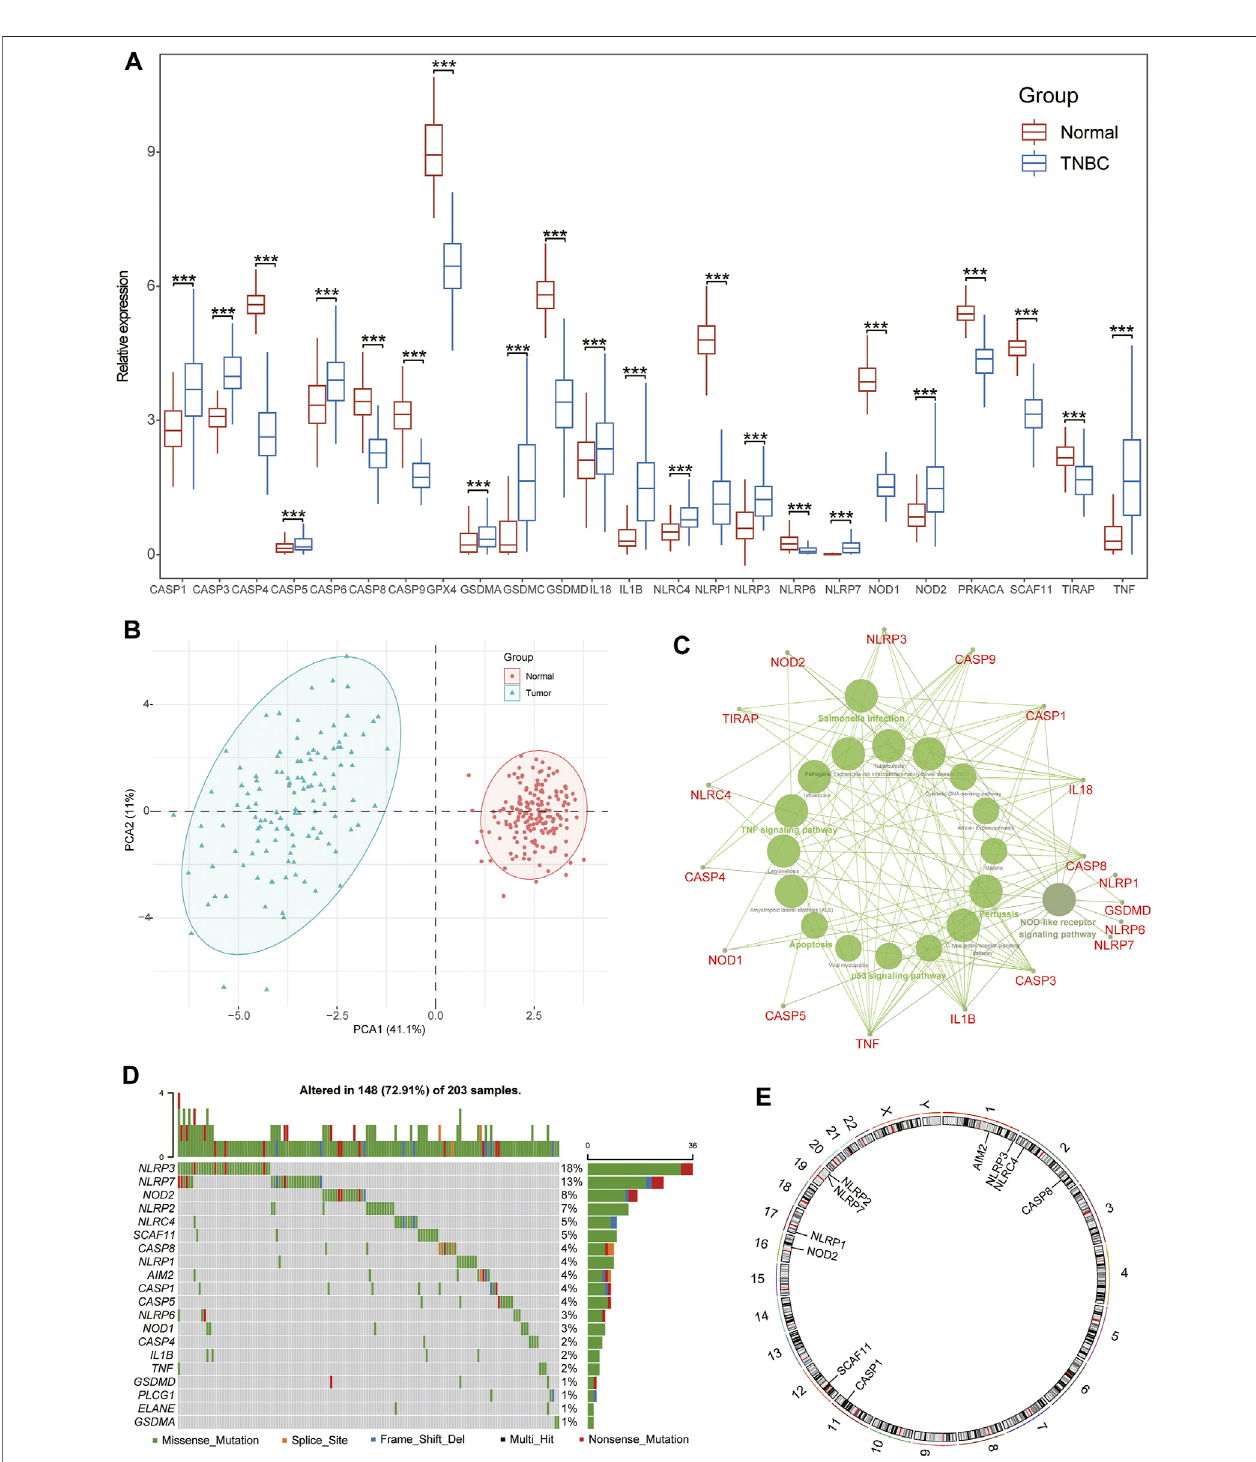
FIGURE 1 | Characteristics of pyroptosis-related signatures in patients with TNBC. (A) The expression of pyroptosis-related signatures between normal tissues and TNBC tissues from GTEx and TCGA data sets; Wilcox test, * p < .05, ** p < .01, *** p < .001; ns, not statistically signi fi cant. (B) PCA showing pyroptosis-related signatures sorted TNBC and control tissues into two clusters. (C) The KEGG functional analysis ofpyroptosis-related signatures. (D) The landscape of mutation pro fi les in patients with breast cancer from TCGA-BRCA cohort. (E) The location of the top 10 pyroptosis-related signatures with the most frequent mutations on the 24 human